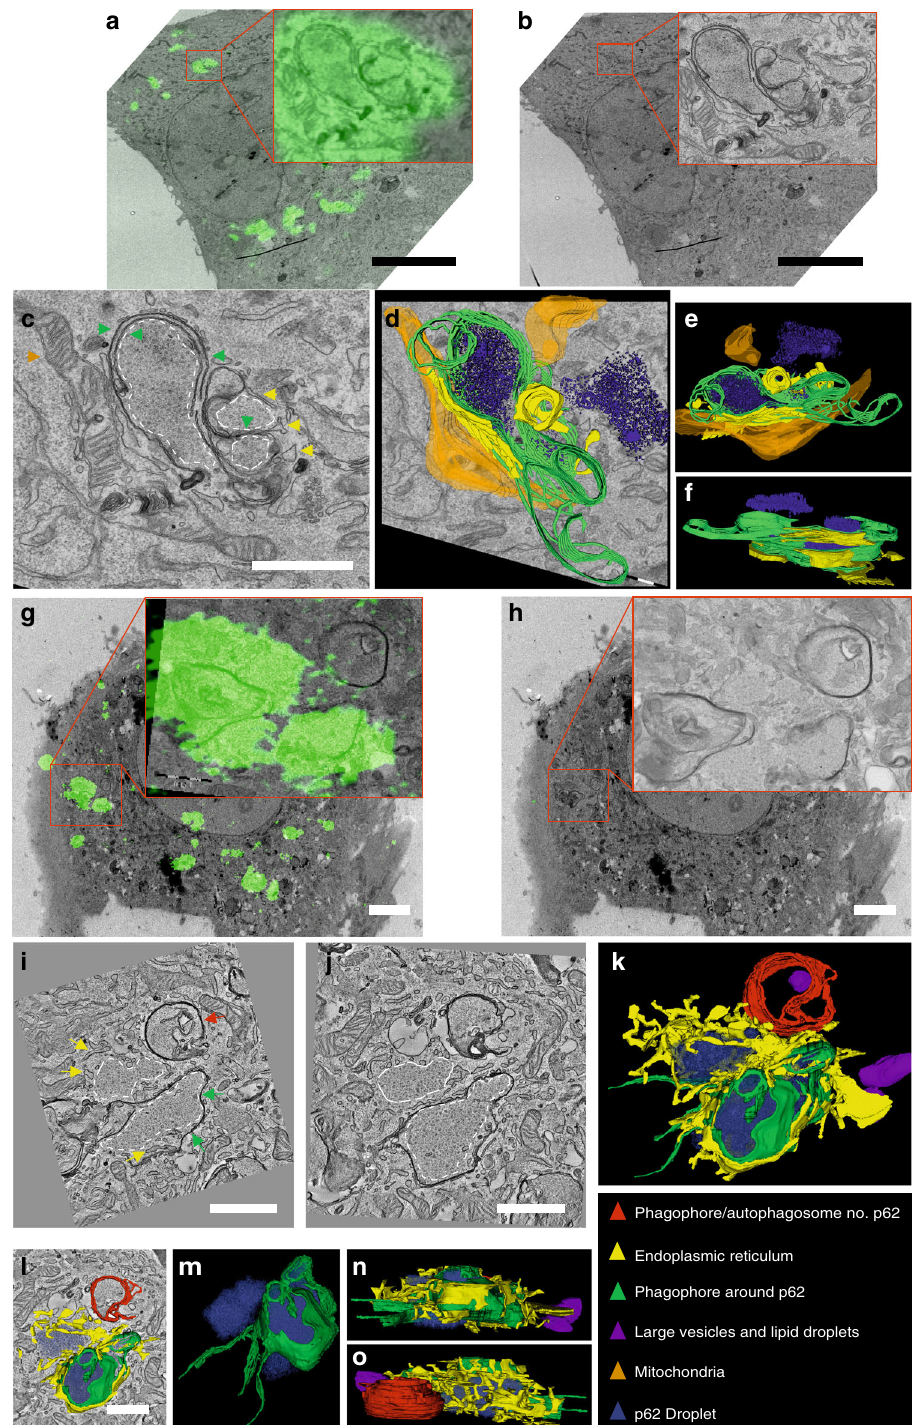
Fig. 2 Ultrastructure and three-dimensional models of autophagic membranes around p62-gels. a – f 80-nm TEM serial sectioning. p62-GFP KI/ + MEFs were treated by sodium arsenite (As[III]) for 10 h and then cultured in regular medium for 3 h. a, b Correlation of GFP fl uorescence and TEM. p62-gels, identi fi ed by their unique morphology and by correlation with the GFP fl uorescence, are indicated by dotted lines in panels c , i and j . Bars: 10 μ m. c The p62- gels are surrounded by single or multiple isolation membranes/phagophores or autophagosome limiting membranes (green arrows). Endoplasmic reticulum (yellow arrows) is observed next to the p62-gels and isolation membranes/phagophores or autophagosomes. Bar: 1 μ m. Panels d – f show a three- dimensional model segmented using aligned 80-nm TEM serial sections. The color code is shown in the bottom right panel. g, h Correlation of GFP fl uorescence and a 200-nm TEM section used for tomography. Bars: 5 μ m. i, j Single views from the electron tomogram, showing p62-gels (dotted lines), an isolation membrane/phagophore containing p62-gel (green arrows), and an isolation membrane/phagophore or autophagosome that does not contain p62-gel (red arrow). Bars: 0.5 μ m. Panels k – o show a three-dimensional model segmented using four aligned 200-nm electron tomograms. The color code is shown in the bottom right